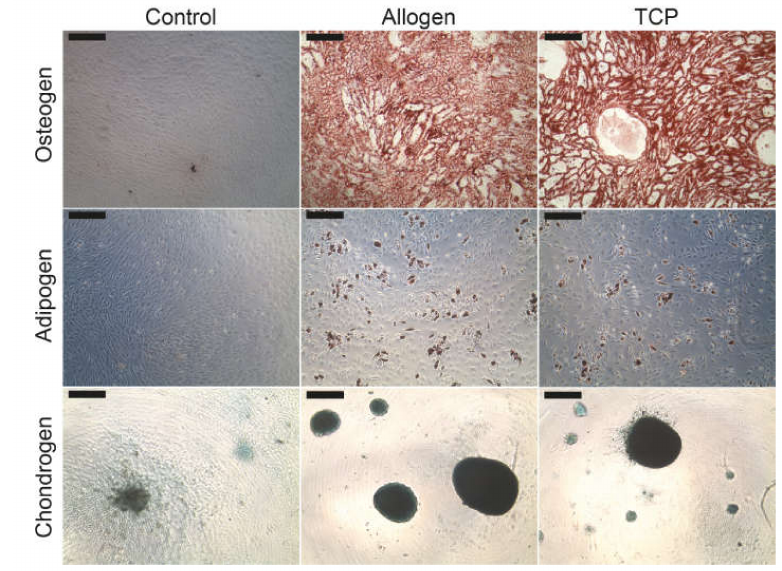
Figure 3. Di ff erentiation of the MSC into osteoblasts, adipoblasts and chondroblasts. The scale bar represents 200 µ